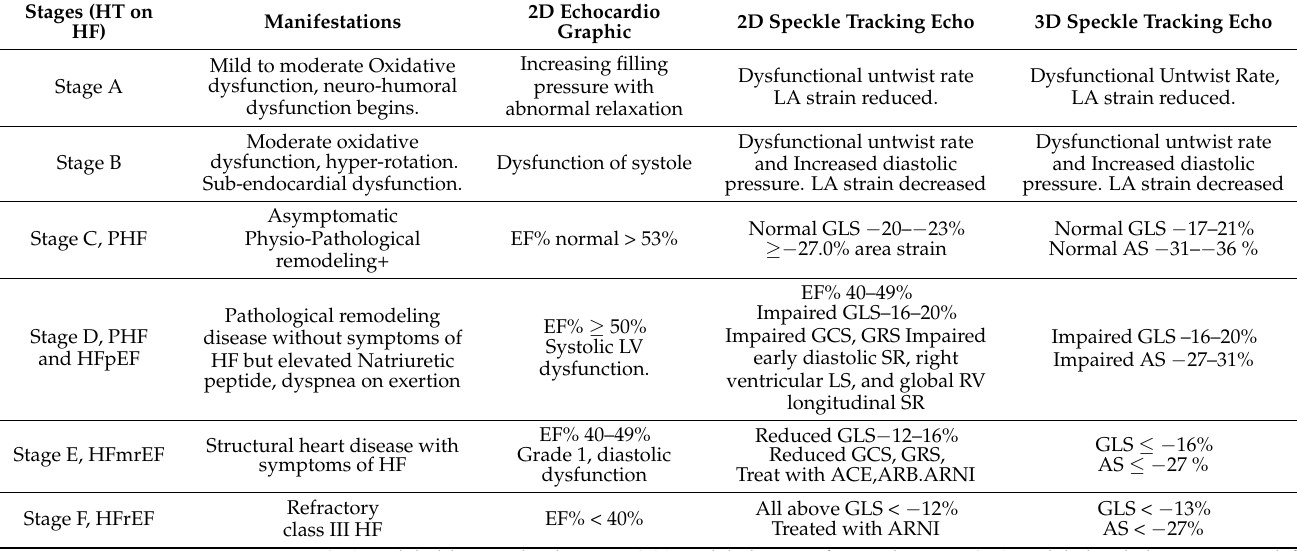
Table 1. Clinical and echocardiographic features of six stages of heart failure with oxidative